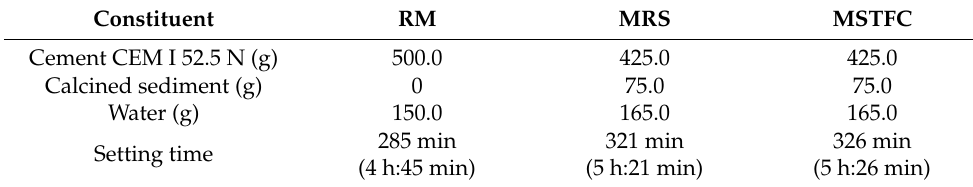
Table 7. Mortar composition of RM, MRS, MSTDC, and MSTFC for the initial setting time VICAT test (NF EN 196-3)